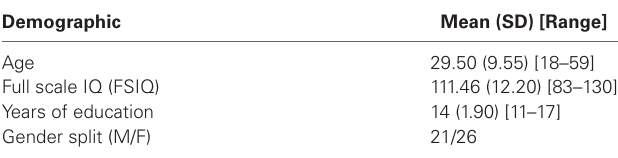
Table 1 | Demographic data of participants ( n = 46)